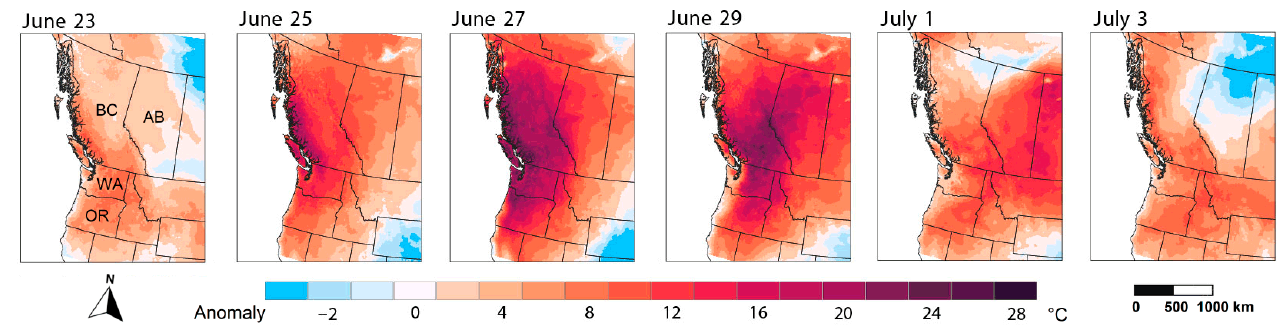
Figure 1. Western Canadian heat wave of June/July 2021, with deviations from climate normal conditions in excess of +25 °C, and record-setting absolute temperatures above 45 °C in British Columbia (BC), Alberta (AB), Washington (WA) and Oregon (OR). The maps represent daily anomalies for the year 2021, relative to 40 years of available gridded 5th generation ERA5 data (1951–1990).